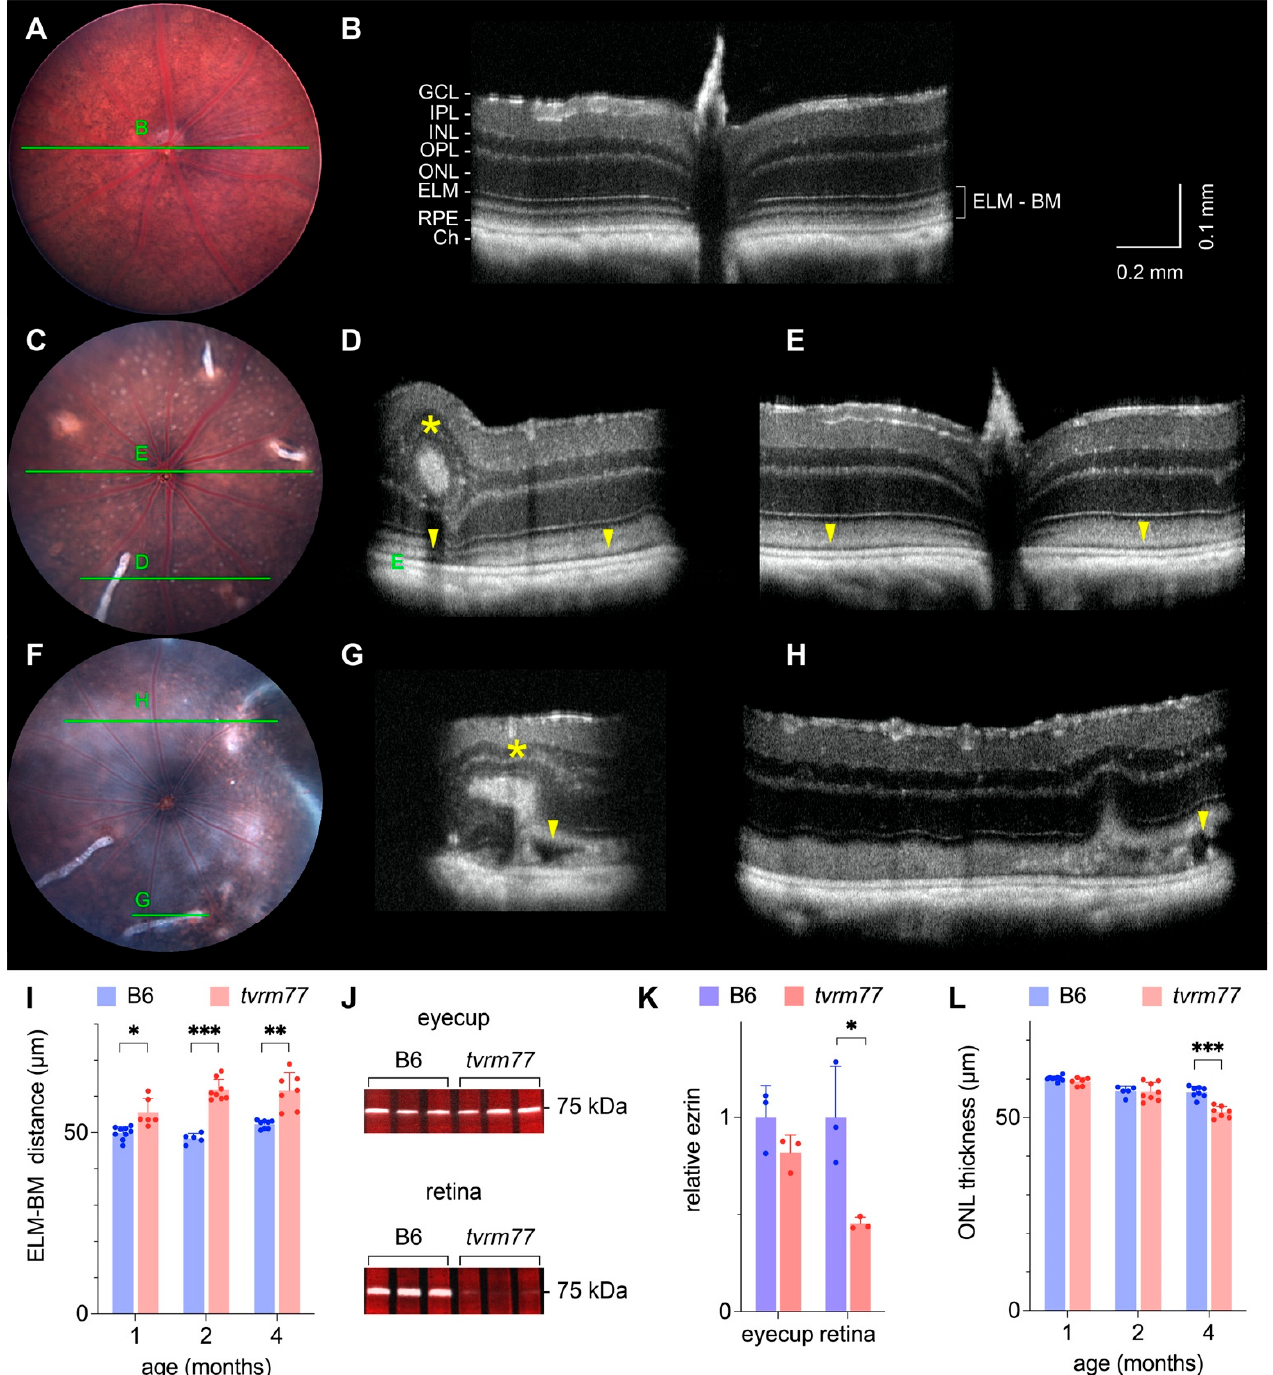
Figure 4. Non-invasive imaging of white-line lesions at 2 and 4 months of age. ( A ) Bright-field fundus image of a B6 eye at 4 months of age. ( B ) B-scan taken from an OCT volume dataset of the same eye. The full OCT dataset is presented in Video S5. Layers are labeled as in Figure 3. ( C ) Fundus images of tvrm77 eye at 2 months of age. Green lines mark the locations of the corresponding OCT B-scans. ( D , E ) B-scans taken from an OCT volume dataset of the same eye. Hyporeflective regions (arrowheads) indicating subretinal fluid between the RPE and retina are evident below white-line lesions (asterisk) and in regions where lesions are not apparent. The full OCT volume dataset is presented in Video S6. ( F ) Fundus images of tvrm77 eye at 4 months of age. Overall haziness of the image is more apparent than at 2 months of age. ( G , H ) B-scans of the same eye indicate more pronounced hyporeflective regions (arrowheads) both below white-line lesions (asterisk) and in regions where lesions are not apparent. The full OCT volume dataset is presented in Video S7. Fundus